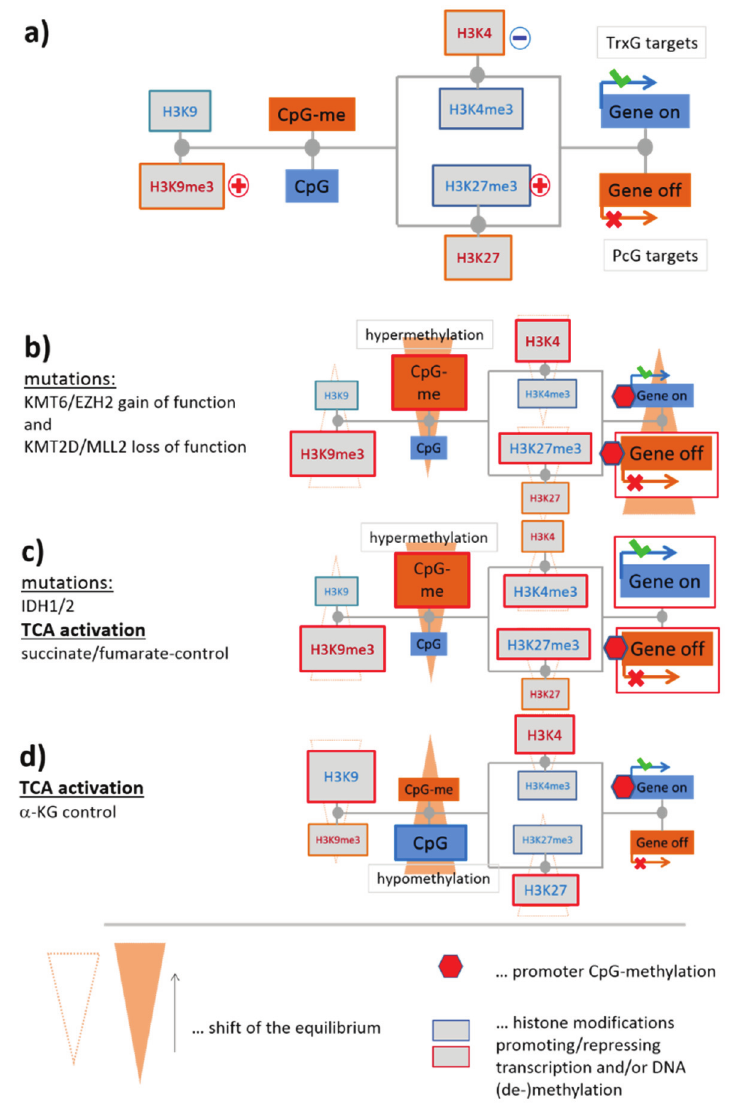
Figure 4. Effect of selected mutations of epigenetic modifiers and of tricarboxylic acid (TCA) metabolism on CpG methylation and gene expression: ( a ) Simplified sketch of the scheme shown in Figure 3. The plusses and the minus indicate gain and loss of function mutations, respectively; ( b ) The scheme suggests that mutations of EZH2 and MLL2 result in DNA-hypermethylation and de-activation of transcription. Alterations are shown by enlarged boxes and red frames in the simplified scheme; ( c ) IDH1 mutations will inhibit a series of KDMs via 2-HG produced by mutated IDH1. It results in hypermethylation and alterations of gene expression in both directions. The same trend is expected for increased TCA-activities with increased levels of fumarate and succinate. Both metabolites inhibit the same modifiers as 2HG; ( d ) TCA activation with increased amounts of (cid:2)-KG will have the opposite effect as in ( c ): it will demethylate DNA and downregulate expression. Note that global changes of methylation (as indicated by “CpG-me”) are paralleled by local ones due to the hypothesized alterations of gene expressions: red marks indicate promoter methylations in ( b – d ) recruited by polycomb group (PcG)-repressed and/or trithorax group (TrxG)-deactivated